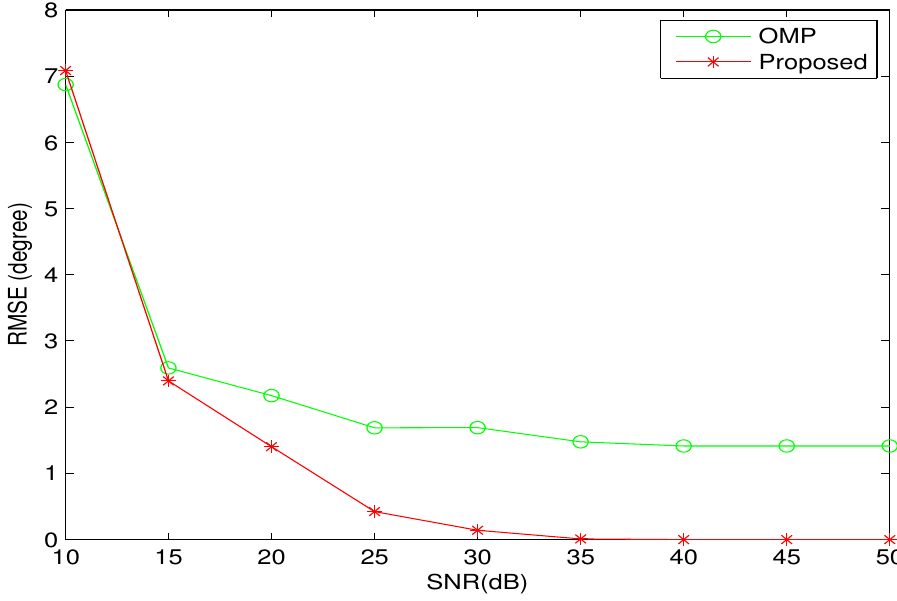
Figure 2. Root mean square error as a function of the signal-to-noise ratio ( SNR ). Five sources are assumed from the DOAs: {− 66 ◦ , − 41 ◦ , − 16 ◦ , − 9 ◦ , − 34 ◦ } . The number of array elements is M = 12 , and the number of snapshots is one. The curves were obtained by averaging the results of 100 independent simulation